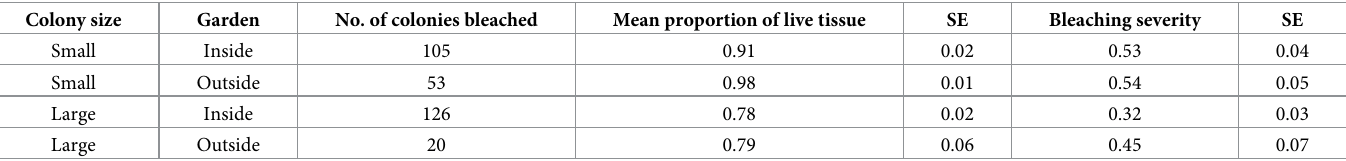
Table 1. Bleaching severity of corals as a function of colony size and farmerfish garden status. Colony size Garden No. of colonies bleached Mean proportion of live tissue SE Bleaching severity SE Small Inside 105 0.91 0.02 0.53 0.04 Small Outside 53 0.98 0.01 0.54 0.05 Large Inside 126 0.78 0.02 0.32 0.03 Large Outside 20 0.79 0.06 0.45 0.07 The mean ( ± SE) proportion of live tissue of an individual coral colony and mean ( ± SE) bleaching severity (i.e., proportion of live tissue bleached) as a function of coral colony size class (small: � 10 cm dia; large > 10 cm) and farmerfish garden status (inside vs outside); N = 1,137 Pocillopora colonies encountered on 178 bommies; corals were categorized as bleached if � 5% of live tissue was